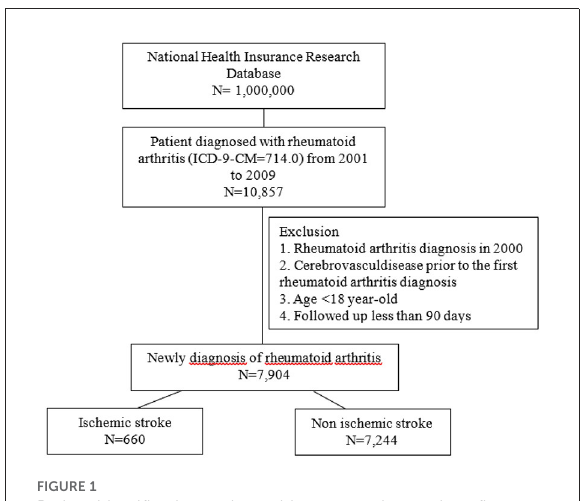
FIGURE1 Patient identification and matching comparison cohort flow